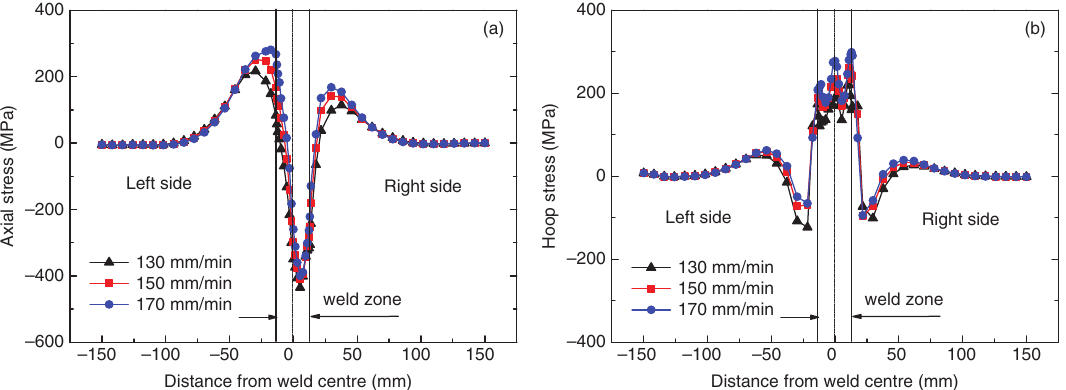
Figure 8: Residual stresses distributions at different arc travelling speeds along path 3: axial stress (a), hoop stress